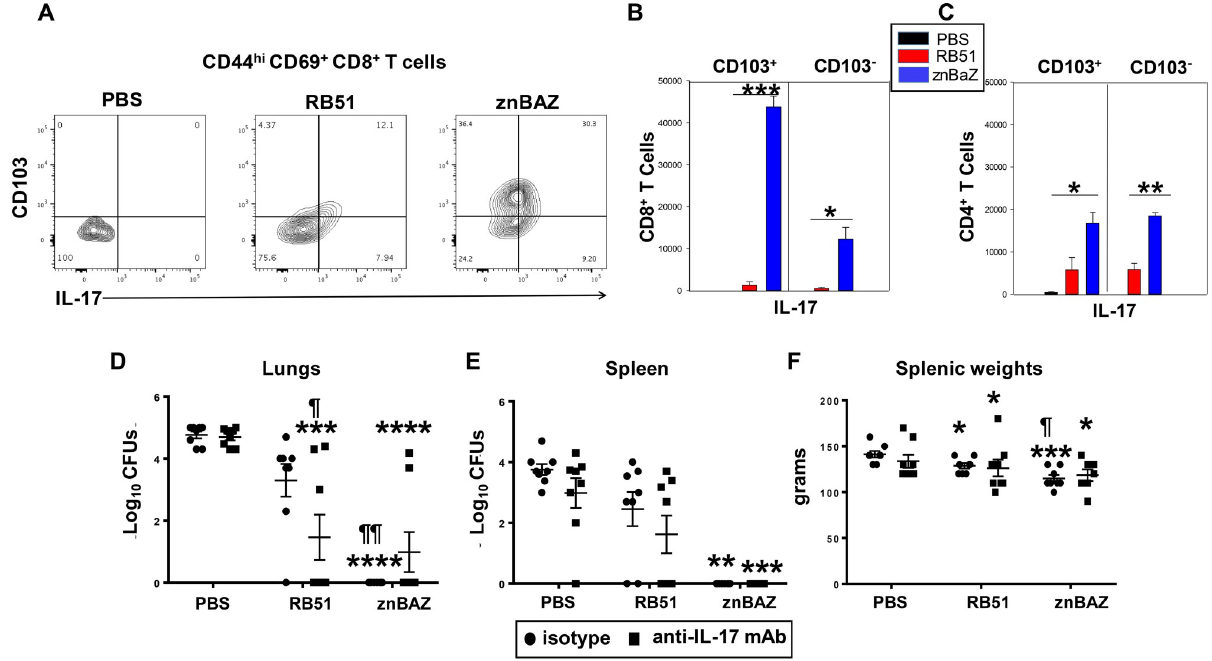
Fig 8. znBAZ induces IL-17 production, but not required for protection against wt B . abortus challenge. Groups of BALB/c mice were orally primed, nasally boosted with sPBS, RB51, or znBAZ as described in Fig 1A, and on day 42 post-primary immunization, gated lung CD44 hi CD69 + CD8 + T RM cells were evaluated (A, B) to determine the source of IL-17 production by CD103 + and CD103 - T RM subsets. The total lung CD103 + and CD103 - (B) CD8 + T RM cells and (C) CD4 + T EM cells producing IL-17 were quantified; ��� P < 0.001, �� P < 0.01, � P < 0.05, significant differences against sPBS- dosed or RB51-vaccinated mice are shown analysis of variance with One-way ANOVA Tukey‘s multiple comparisons test. (D-F) Additional groups of BALB/c mice were vaccinated in the same manner, and then challenged with virulent B . abortus 2308 as described above. Half of all mice were treated with isotype control Ab and the other half with anti-17 mAb on days -1, 2, 7, and 12 post-challenge. Two weeks after challenge, extent of brucellae colonization of the (D) lungs and (E) spleens were measured. (F) Splenic weights were also measured. Analysis of variance with Two-way ANOVA Tukey’s multiple comparisons test was performed: ���� P < 0.0001, ��� P < 0.001, �� P < 0.01, � P < 0.05, versus isotype control-treated sPBS-dosed